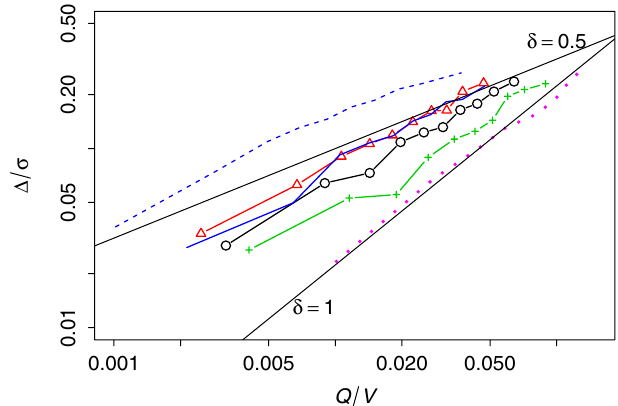
FIG. 4. Impact of metaorders on log-log scale. We show (cid:1) =(cid:1) vs Q=V , where (cid:1) and V are measured over the time scale (cid:7) life . The three curves with symbols show the impact for the (cid:11) execution with high participation rate, (cid:2) ¼ 0 : 3 , and three values of the sign autocorrelation exponent: (cid:10) ¼ 0 : 3 (green crosses), (cid:10) ¼ 0 : 5 (black circles), (cid:10) ¼ 0 : 8 (red triangles). The two blue lines show the impact for low participation rate (cid:2) ¼ 0 : 05 , for the (cid:11) execution (full line) and unit execution (dashed line), both for (cid:10) ¼ 0 : 5 . The purple dots show a case when the time to complete metaorders is longer than the lifetime of the book T > (cid:7) life . In this case we get back a linear impact. The two solid black lines are of slope (cid:2) ¼ 0 : 5 and (cid:2) ¼ 1 , for comparison, with the choice Y ¼ 1 for (cid:2) ¼ 0 : 5